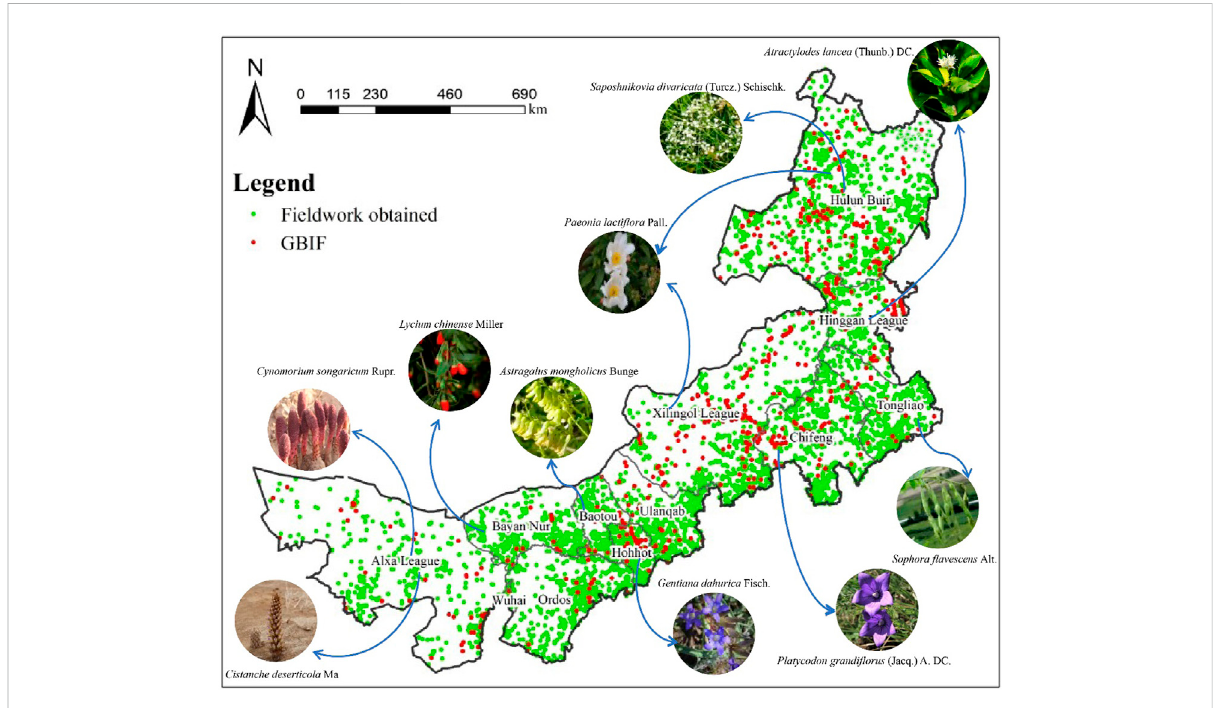
FIGURE 1 Sampling points of the distribution of medicinal plants in Inner Mongolia (The plants in the picture have a relatively wide distribution in various places.GlobalBiodiversityInformationFacility(GBIF)databaseisaninternationalnetworkanddatainfrastructurefundedbygovernmentsworldwide and aims to provide open access to data about all types of life on Earth. The distribution data of medicinal plants with distribution in Inner Mongolia were screened from this